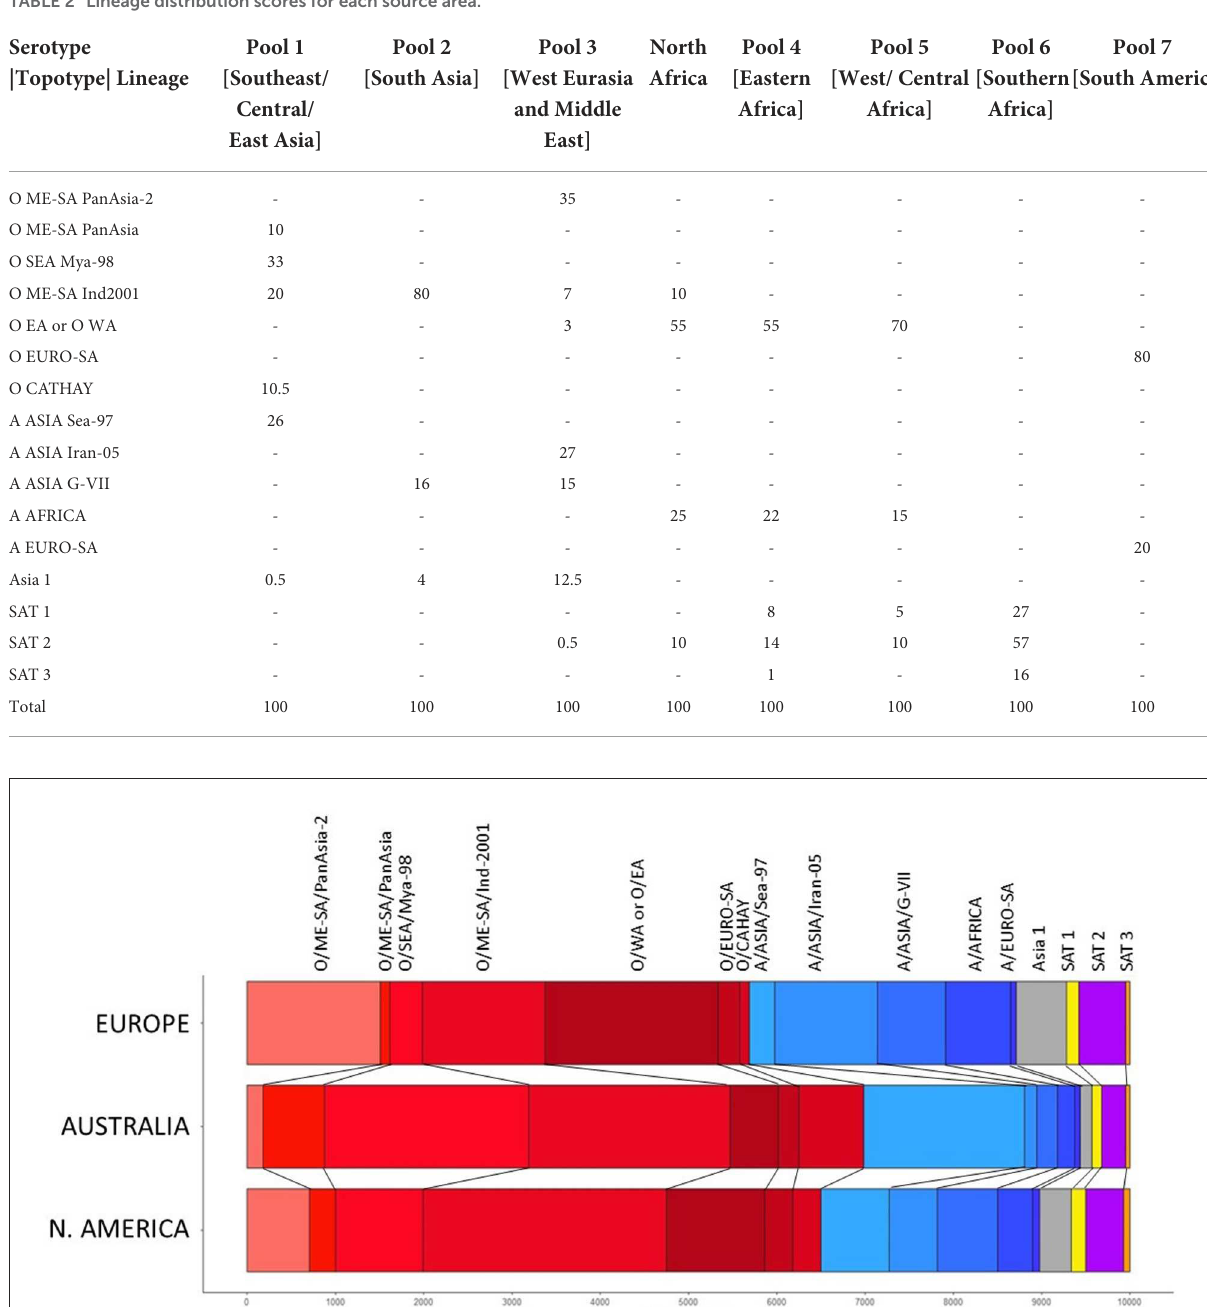
TABLE 2 Lineage distribution scores for each source area.